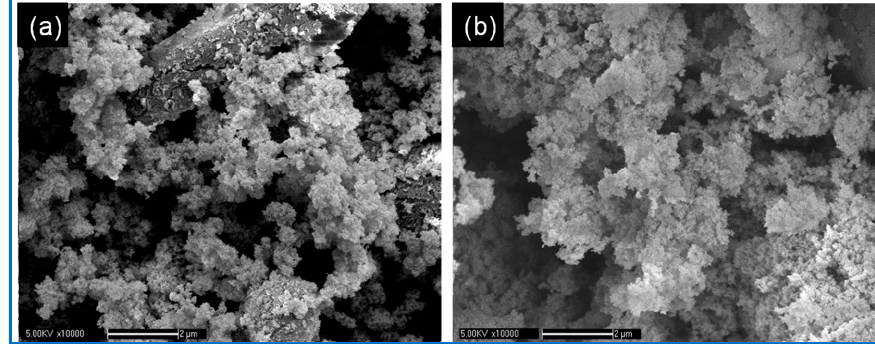
Figure 3. SEM images of Al/Fe2O3/RDX nanocomposites prepared using ( a ) cyclohexane or ( b ) both cyclohexane and acetone.